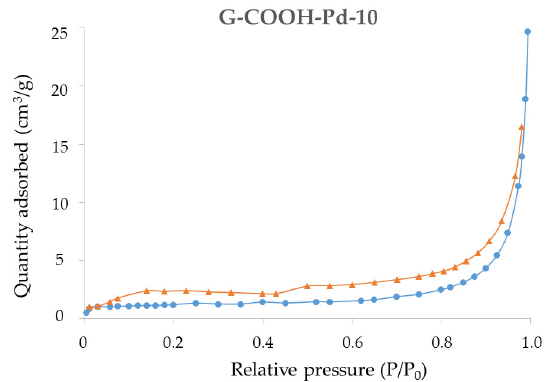
Figure 2. N 2 adsorption ‐ desorption isotherm of material G ‐ COOH ‐ Pd ‐ 10.